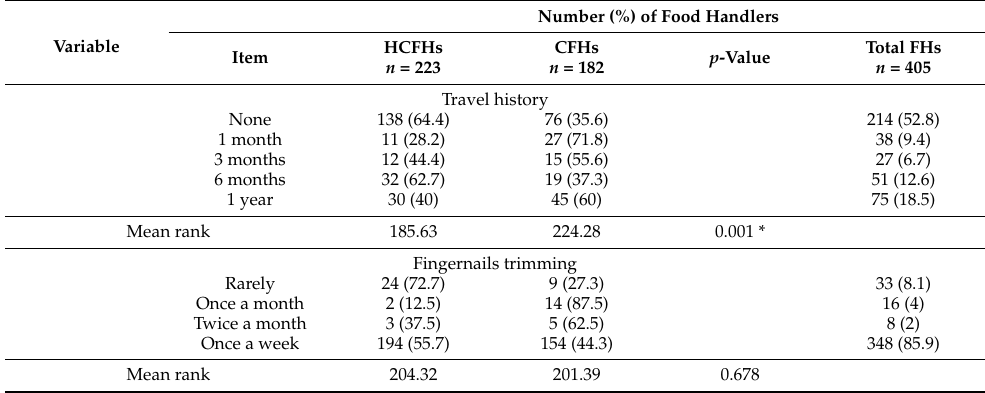
Table 3. Travel history and frequency of fingernail trimming habits of healthcare and community food handlers.